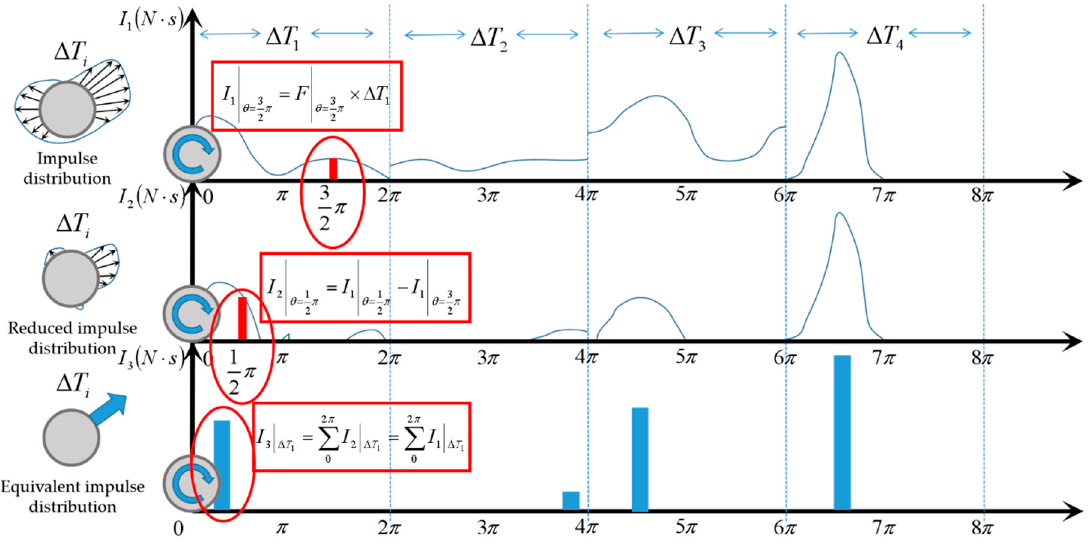
Figure 10. Diagram of impulse model.